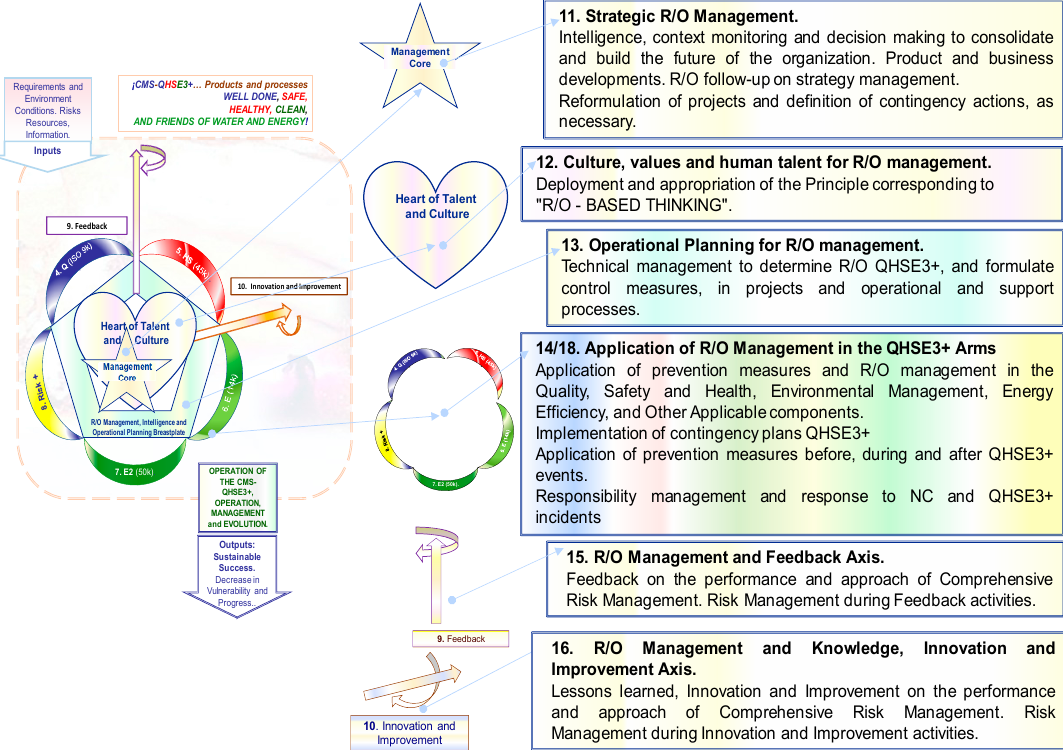
Figure 7. Model for the comprehensive R/O management of CMS QHSE3+.